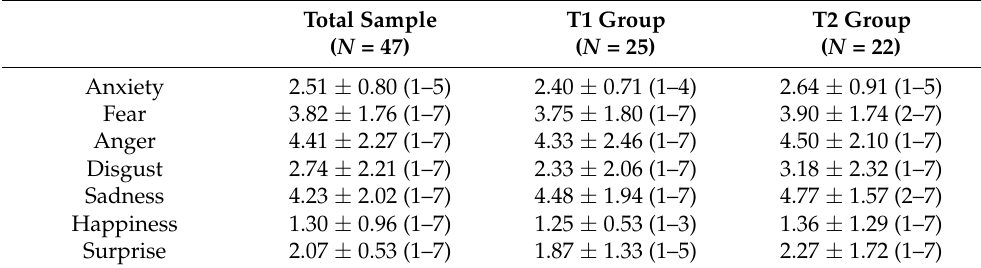
Table 2. Emotional reactions to the pandemic.